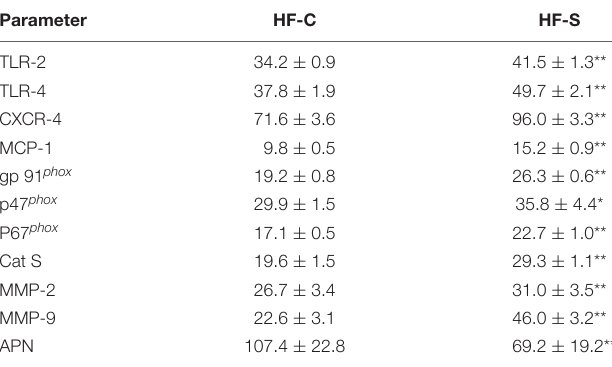
TABLE 3 | Real-time PCR analysis of the targeted genes in the aortic roots and APN in subcutaneous fat of both experimental group